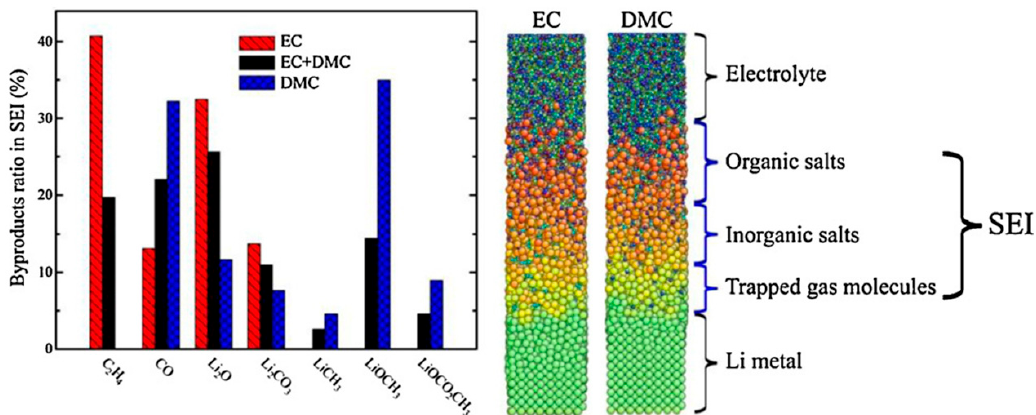
Figure 8. Distribution of the SEI components for different electrolytes ( left chart). Atomic configurations from MD simu- lations; the components of the SEI are identified ( right ) [41].